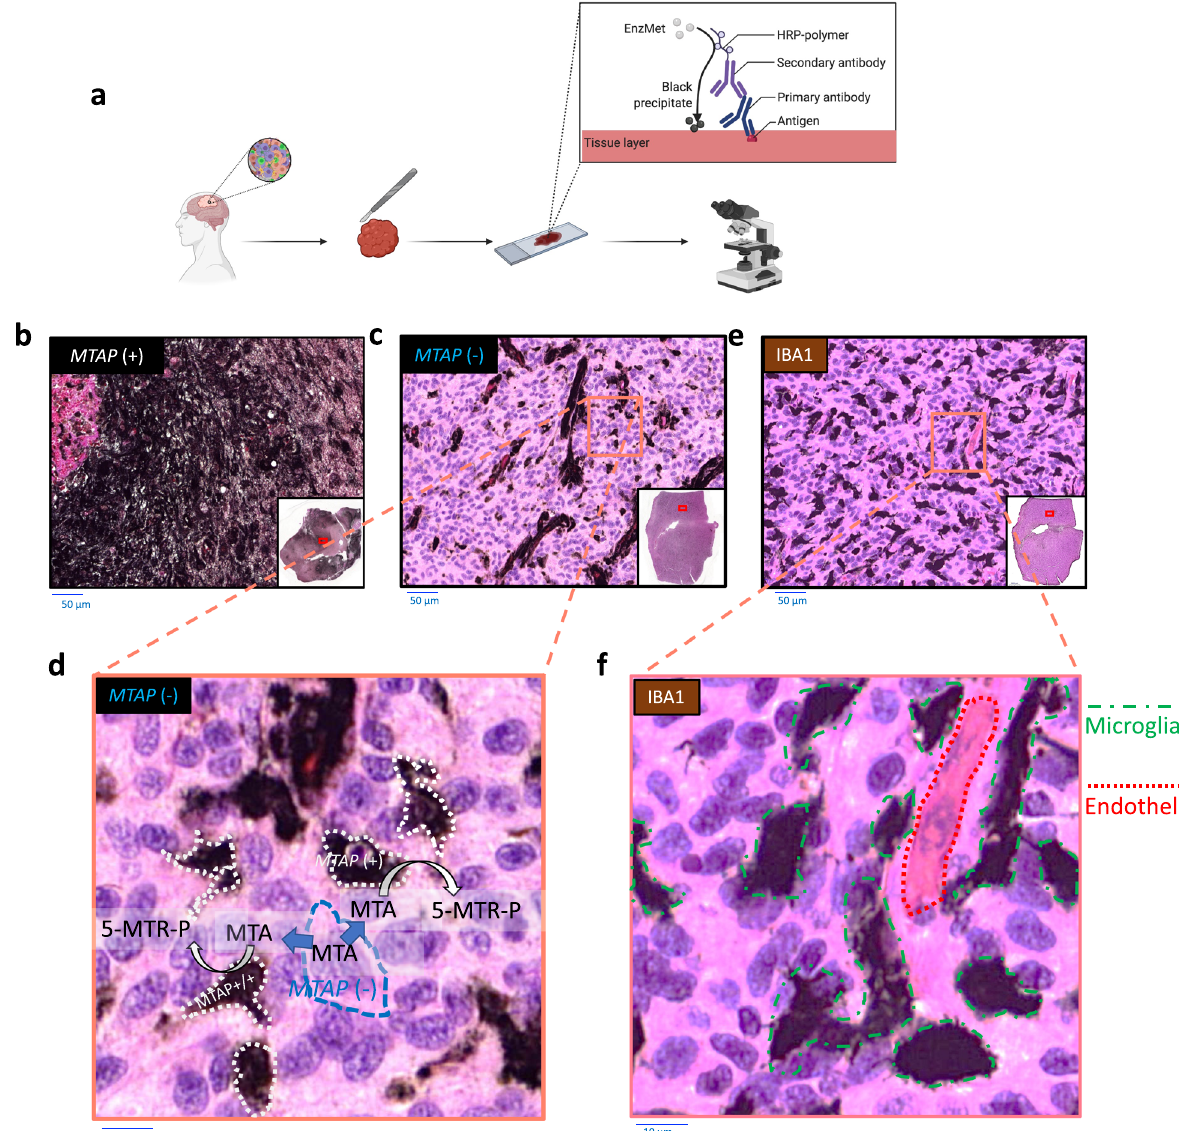
Fig. 3 Primary GBM tumors are extensively in fi ltrated by MTAP-expressing non-malignant stromal cells. a Immunohistochemistry (IHC) for MTAP and IBA1 on formalin- fi xed paraf fi n-embedded (FFPE) sections of GBM tumors. b , c IHC was performed with monoclonal anti-MTAP. The slides were developed with EnzMet (black staining indicates MTAP expression) and counterstained with hematoxylin (blue, nuclei) and eosin (pink, cytosol, and extracellular space) on at least 50 cases stained with MTAP and IBA1 and representative of three independent cases are shown. Representative sections of MTAP - positive ( b ) and an MTAP -negative GBM tumor ( c ); x20 objective. Note the extensive MTAP-positive staining areas on the background of otherwise non- staining MTAP -negative glioma cells; histopathologic evaluation of morphology indicates that these MTAP -positive cells correspond to stromal components, including microglia, endothelial cells, and activated astrocytes. d Higher magni fi cation view of c golden square. Any MTA secreted by MTAP - deleted glioma cells (blue dashed outline) stands to be phosphorylated by MTAP (producing 5-MTR-P) either released or taken up by MTAP-expressing stromal cells (white dashed outlines). e A representative section of an MTAP -negative GBM tumor stained against IBA1 antibody (myeloid marker), indicating the extensive presence of myeloid cells (microglia/macrophages) inside GBM tumors. f Higher-magni fi cation view of e